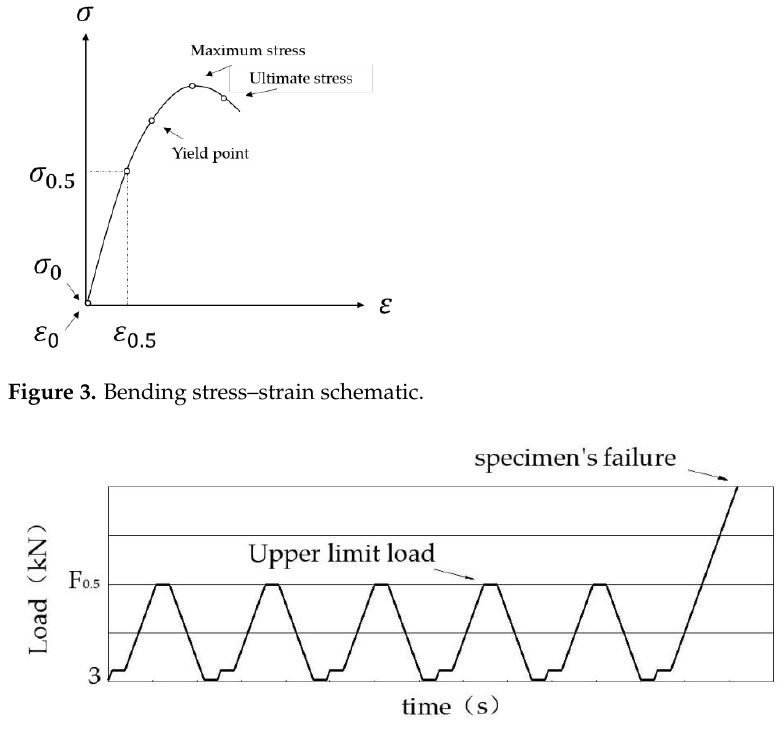
Figure 4. Loading cycle schematic.